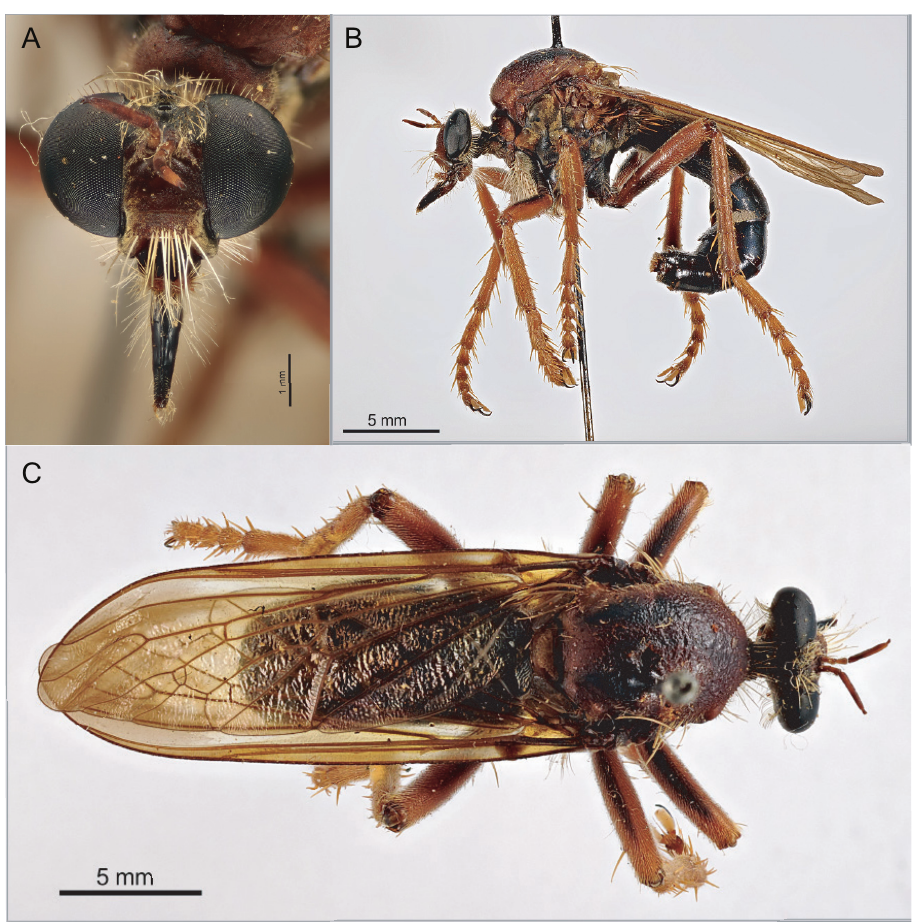
Figure 8. Saropogon birdi Curran, 1931 Female holotype A anterior view B lateral view C dorsal view. Photograph provided by American Museum of Natural